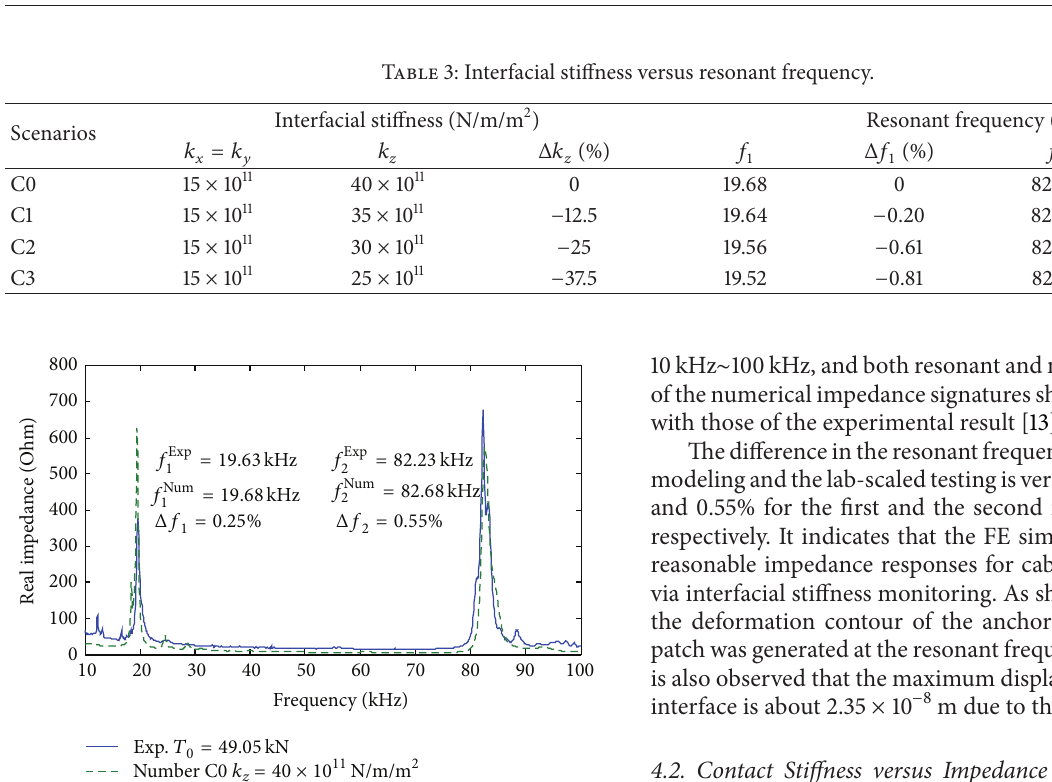
result (for tension force 49.05 kN). It is worth noting that the